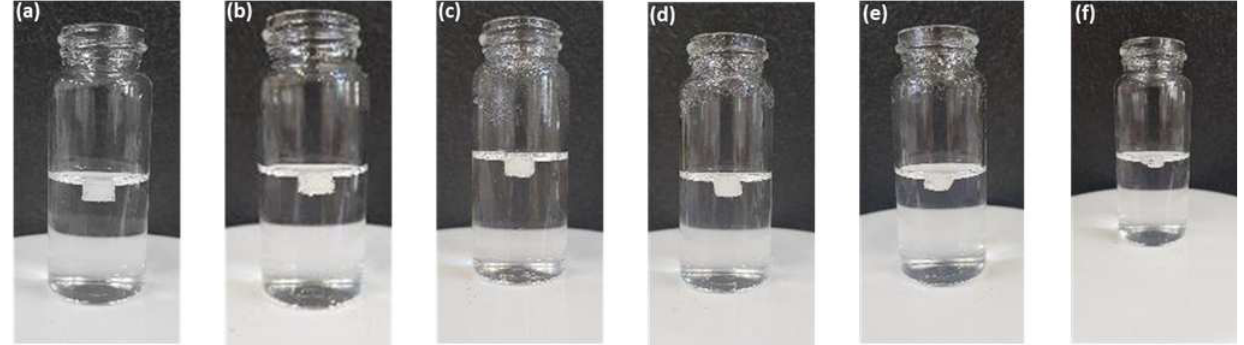
Figure 10. Images of 3D-printed tablet; F2 (2 shells with 0% infill) floating in dissolution medium (0.1 N HCl solution) at 37 ± 0.5 °C ( a ) t = 2 h; ( b ) t = 4 h; ( c ) t = 6 h; ( d ) t = 8 h; ( e ) t = 10 h; and ( f ) t =